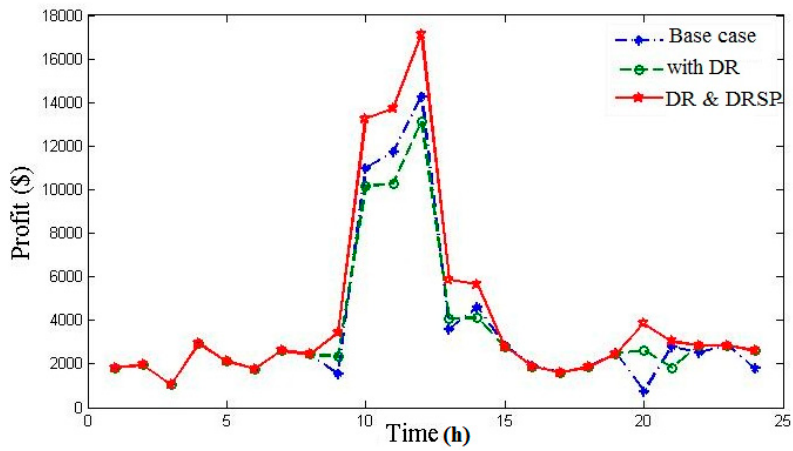
Figure 7. Profit for TUC, TUC using DR and DRUC.